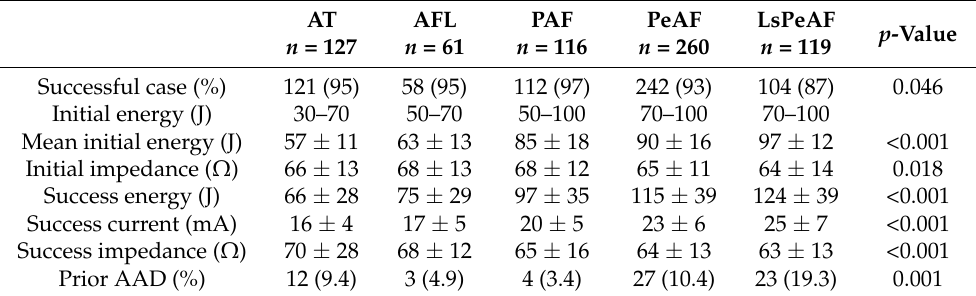
Table 2. Electrical characteristics of the study population according to arrhythmia